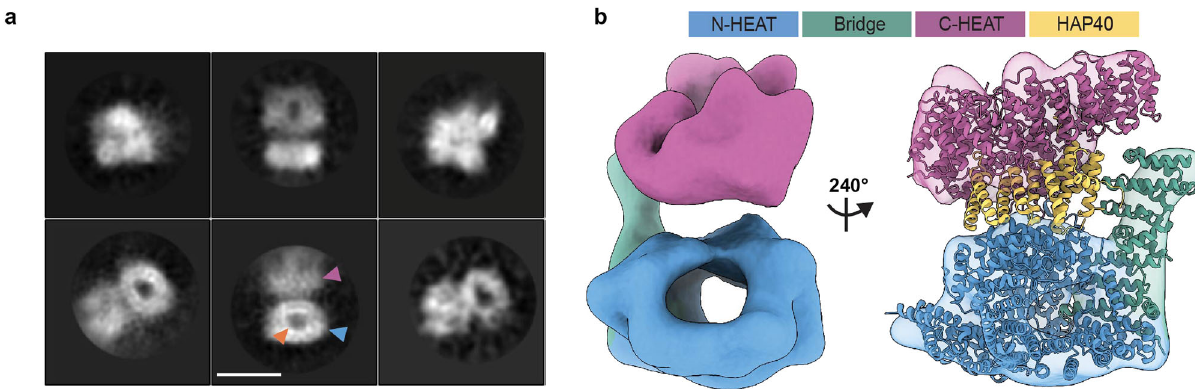
Fig. 3 HTT HEAT domains are conformationally fl exible in the absence of HAP40. a Representative cryo-EM 2D class averages of HTT Q23. Scale bar (white) shown in the bottom middle panel is 90 Å. Blue arrowhead denotes the N-HEAT domain in which its central cavity (orange arrowhead) is more clearly de fi ned. Purple arrowhead denotes the less well-de fi ned C-HEAT domain, perhaps due to conformational fl exibility relative to the N-HEAT. b Cryo- EM volume of HTT resolved to ~12 Å shown with model of HTT-HAP40 (PDBID: 6X9O) fi t to the map. Regions of map and model are displayed with N-HEAT in blue, bridge domain in green, C-HEAT in purple and HAP40 in